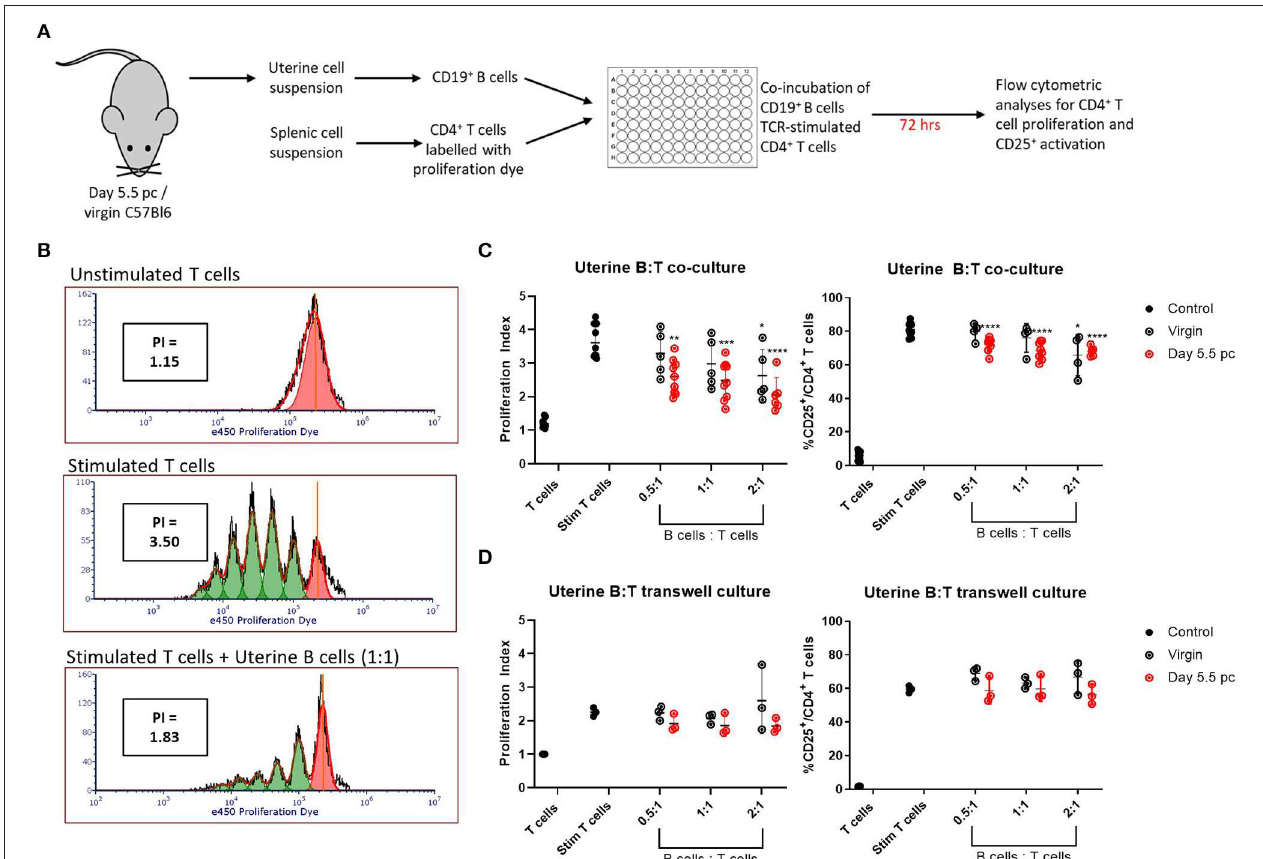
FIGURE 3 | Uterine B cells from pregnant mice post-implantation suppress CD4 + T cell proliferation and activation. (A) Schematic diagram of the suppression assay used to assess the effect of B cells on CD4 + T cell proliferation and activation. (B) Representative flow cytometric panels illustrating the inhibitory effect of B cells on T cell proliferation quantified via calculation of individual proliferation index (denoted as PI). (C) Graphical summaries of biologically independent experiments assessing amount of CD4 + T cell proliferation and CD25 expression with and without co-culture of increasing ratio of uterine B cells. (D) The same experiments as in (C) except T and B cells were kept physically apart by a 0.4 µ m transwell membrane ( n = 3–8). Data is presented as mean ± SEM and compared by one-way ANOVA followed by Dunnett’s post-hoc test. * p ≤ 0.05, ** p ≤ 0.01, *** p ≤ 0.001, **** p ≤ 0.0001. Data were combined from five independent experiments.